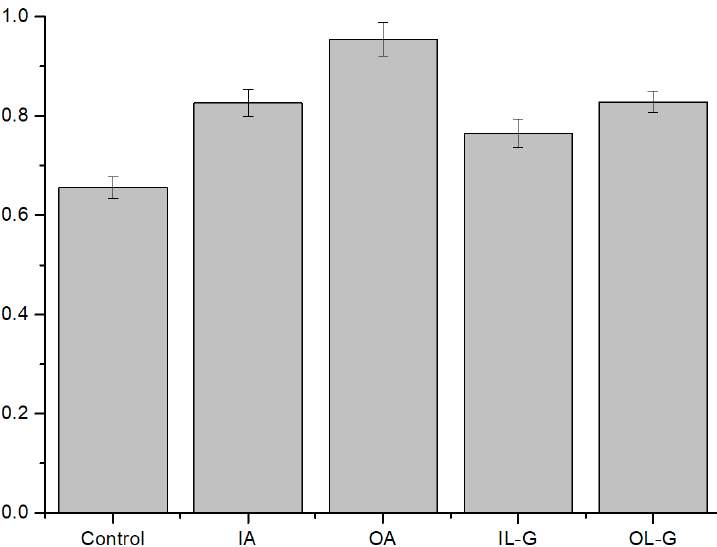
Figure 4. Comparison of the activities of two types of water-soluble antioxidants. There are four kinds of liposomes: inner ascorbate (IA), outer ascorbate (OA), inner L-glutathione (IL-G), and outer L-glutathione (OL-G). Inner refers to inside the liposome, while outer is outside the liposome. The concentration of both the inside and outside antioxidants was 200 μ M. The ratio of the fluorescence intensity difference was analyzed (after light illumination/before light illumination) (N = 8). The smaller the value is, the more unstable it is. The control was an asymmetric liposome. Outer ascorbate showed the highest ROS scavenging effect, followed by inner ascorbate, outer L-glutathione, and inner L-glutathione. (Table S1).